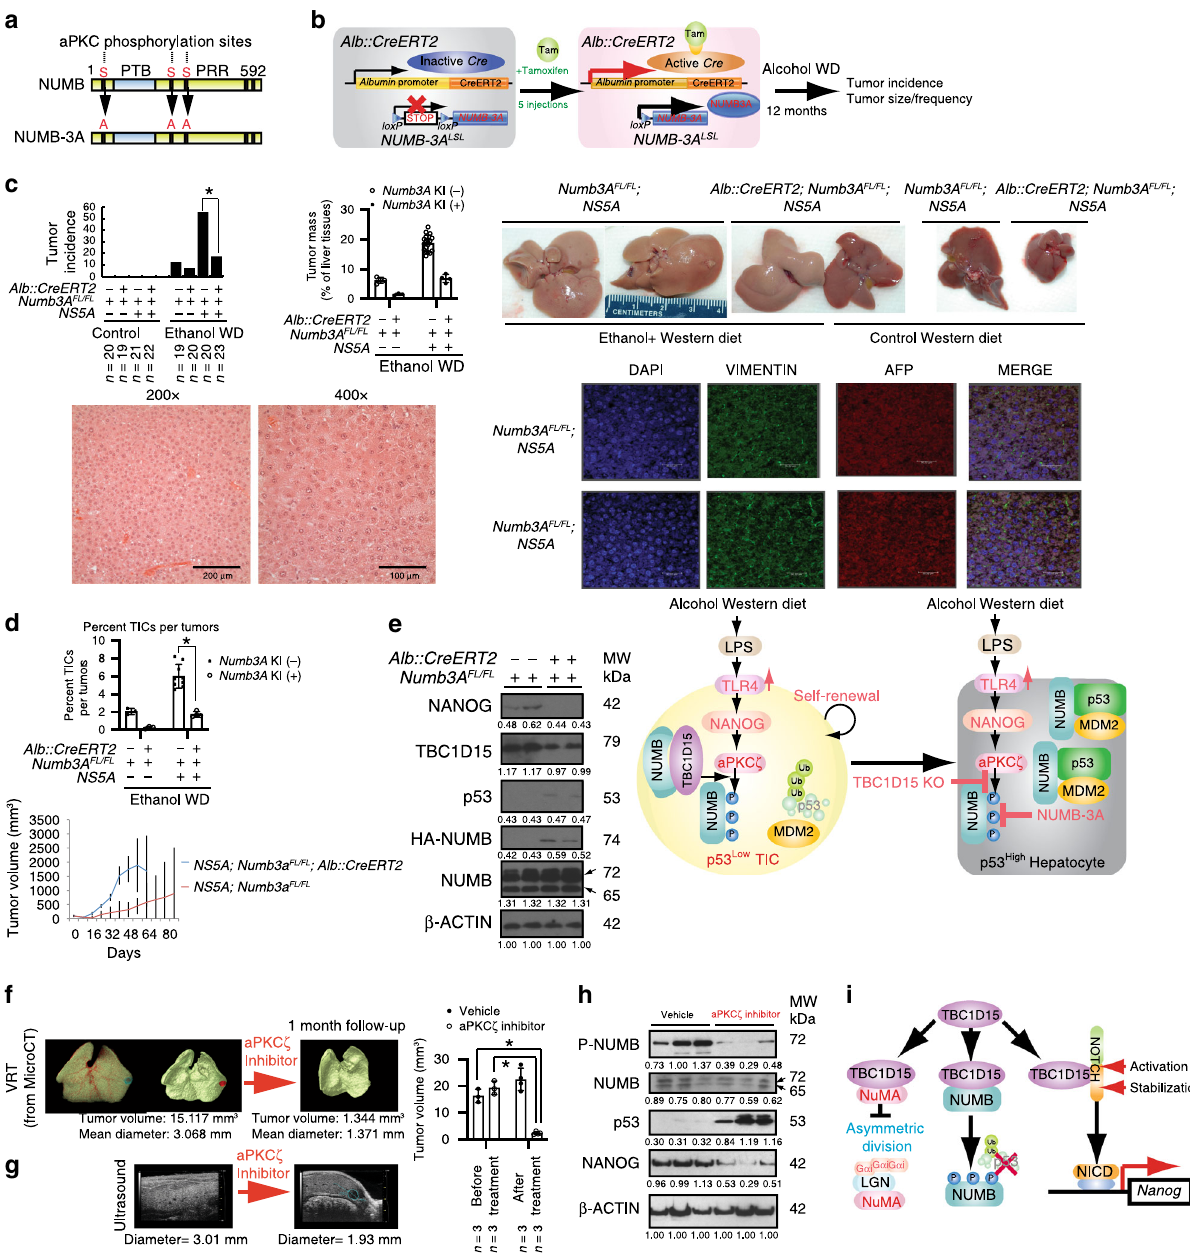
Fig. 6 Targeted expression of a non-phosphorylatable mutant of NUMB reduces HCC development induced by alcohol-HCV synergism mouse model. a Non-phosphorylatable mutant of NUMB (named as NUMB-3A) was generated by serine-to-alanine substitutions of three NUMB phosphorylation sites. b The experimental strategy of tamoxifen-inducible Cre-mediated NUMB-3A expression using Alb::CreERT2 ; NUMB3A LSL ;NS5A mice. c Incidence of liver tumor (upper left panel), ratio of tumor mass/liver weight (%) (upper middle panel) and liver tumor pictures (upper panel, right) of the four groups of mice was decreased in Alb :: CreERT 2; NUMB3A LSL ; NS5A mice with Ethanol WD. The visible tumors were measured at the indicated days. Error bars represent ±SEM ( n = 3). p Values are shown from a chi-square test * p = 0.0003773 (chi-square test). H&E staining for mouse tumors (bottom left panel). Immuno fl uorescence staining of Vimentin and AFP in tumor tissues (bottom right panel). Scale bar, 30.32 μ m. The representative pictures are shown from three independent experiments. d (top) The percentage of CD133 + TICs in tumor cells is compared among the four different genotypes of mice. (bottom) Tumor volume kinetics of TIC-derived tumors. The percentage of TICs of tumor cells were calculated as mean ± SD ( n = 3). p -Values by two-tailed paired t test. * p = 0.022474 (Student ’ s t test). e (left) Immunoblots of tumor cell lysates isolated from hepatocyte-speci fi c expression of NUMB-3A mice. (right) Schematic presentations of LPS-activated TLR4 inducing NANOG mediated NUMB phosphorylation for p53 loss and TIC self-renewal, and of NUMB-3A- antagonism of this pathway. f Micro-CT imaging and texture-based VRT were reduced tumor size and tumor volume. The bar graph shows changes in tumor volume before and after the aPKC ζ inhibitor. Error bars represent ±SEM. p -Values by two-tailed paired t test. * p = 0.00654 (aPKC ζ inhibitor; before vs after treatment), * p = 0.00095 (after treatment; vehicle vs aPKC ζ inhibitor) (Student ’ s t test). g Τ he aPKC ζ inhibitor treatment reduced liver tumors spontaneously developed in HCV NS5A Tg mice fed alcohol Western diet as shown by ultrasound sonography. h Immunoblots of tumor cell lysates isolated from NS5A Tg mice fed alcohol WD of the aPKC ζ inhibitor vs vehicle. i Summary of oncogenic pathways. NUMB phosphorylation and TBC1D15 are mutually required for liver tumorigenesis. Source data are provided as a Source Data fi